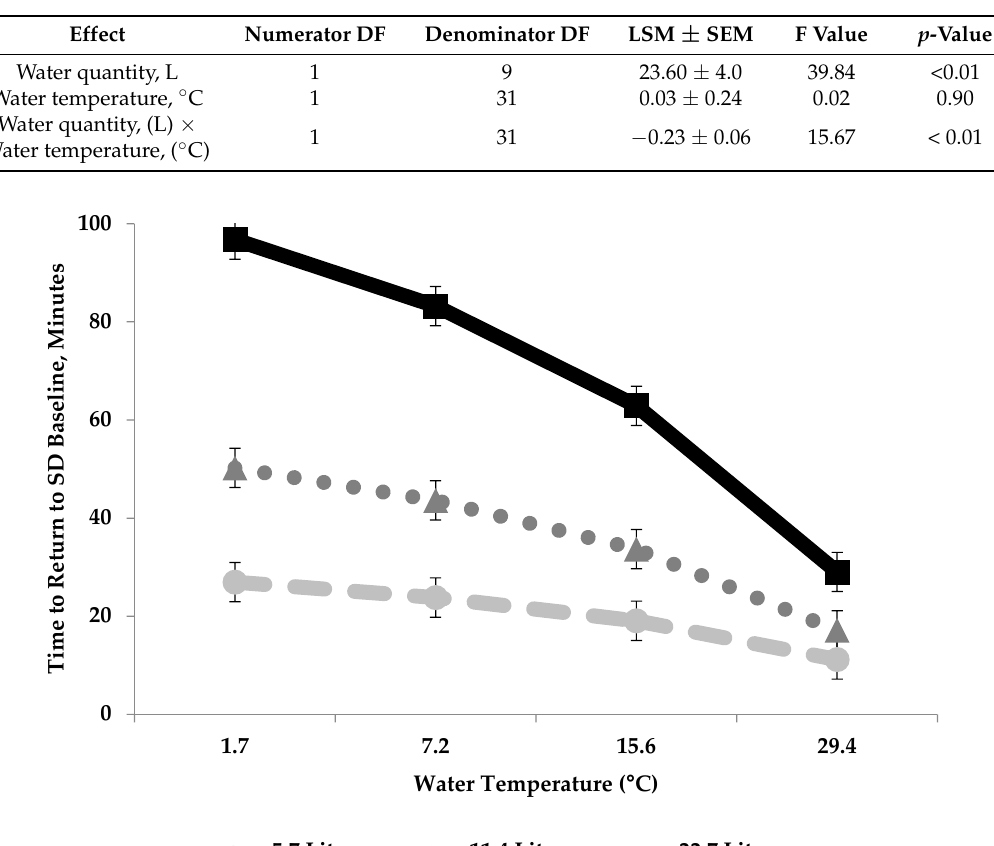
Table 4. Experiment part 2: Effect of water quantity (5.7 L, 11.4 L, 22.7 L), water temperature (1.7 °C, 7.2 °C, 15.6 °C and 29.4 °C) and the interaction using a linear mixed model investigating the time (min) required after a reticuloruminal temperature drop to return to an individual cow’s baseline for experiment part 2 feed restricted, once daily drenched pregnant cows ( n = 12).